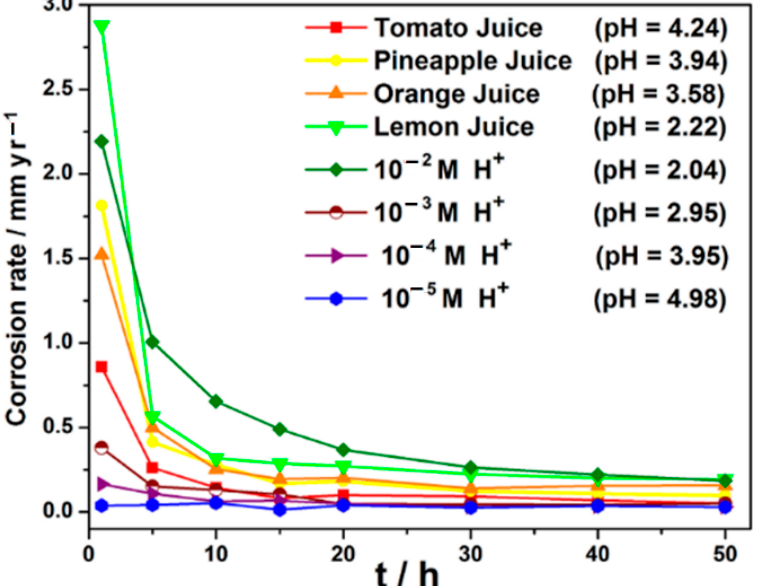
Figure 4. Plot of corrosion rate as a function of immersion time, respectively, for carbon steel in different fruit juices and HCl solutions of comparable pH from gravimetric data.